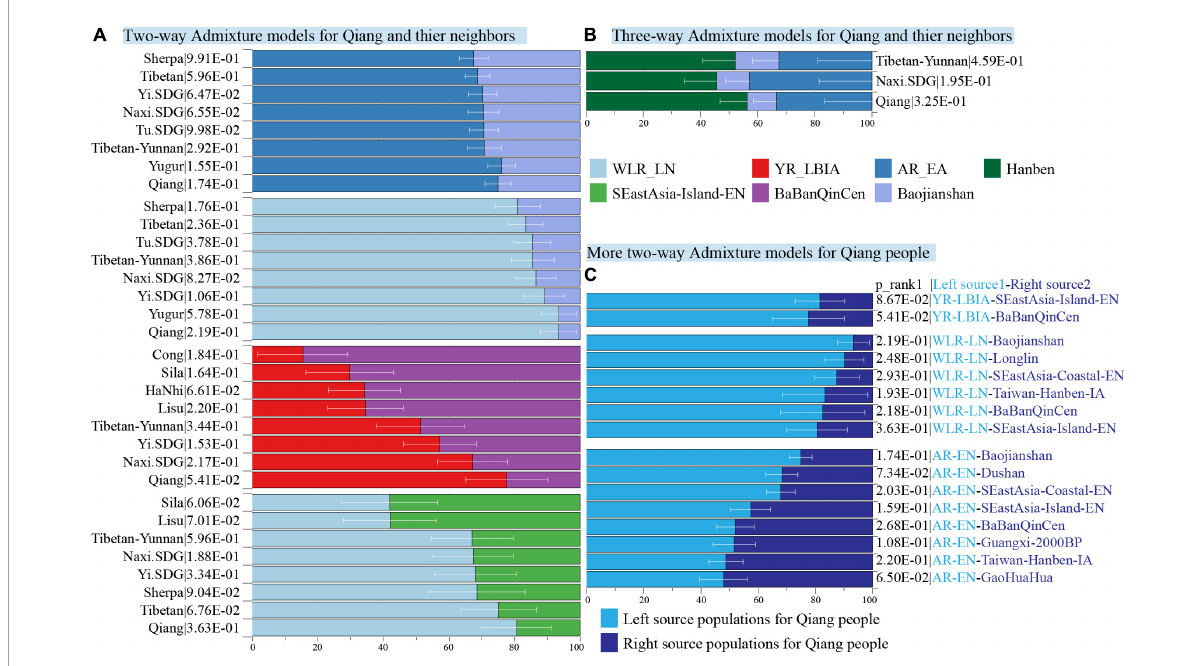
FIGURE8 Results of the qpAdm-based models show the formation of modern Tibeto-Burman-speaking populations with different admixture models. (A) QpAdm models of Tibeto-Burman people with two source surrogates from northern and southern China. (B) Three-way qpAdm admixture models of Tibeto-Burman people with sources from inland and coastal southern East Asians and one northern East Asian source. (C) Two-way admixture models with different sources fitted the gene pool of Qiang people. Error bar denoted the standard error, and different colors showed different ancestral sources. WLR, West Liao River; LN, Late Neolithic; YR, Yellow River; LBIA, Late Bronze Age and Iron Age; AR, Amur River; EA, Early Neolithic Age; EN, Early Age, IA, Iron